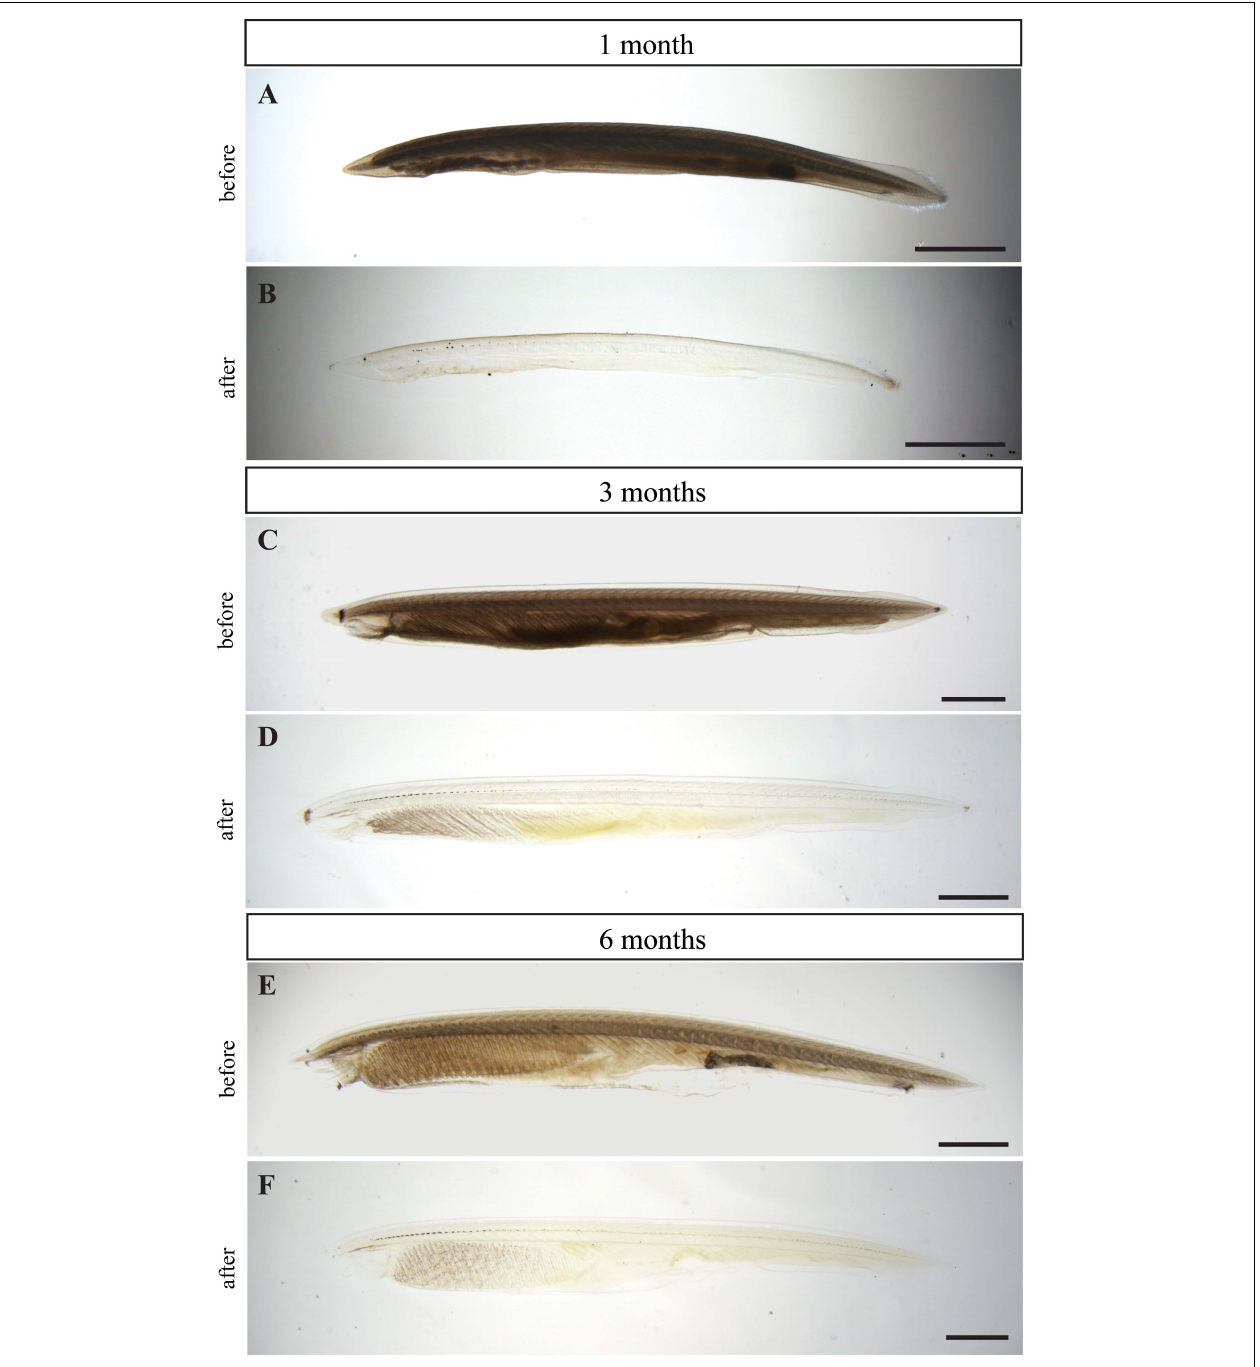
FIGURE 1 | Clearing effect of CUBIC technique on larvae and juveniles of B. floridae . One-month-old larva before (A) and after clearing (B) , 3-month-old juvenile before (C) and after clearing (D) , and 6-month-old juvenile before (E) and after clearing (F) . Larvae and juveniles depicted before and after clearing came from the same batch and were raised in the same conditions. Wide field microscopy with transmitted light was used for imaging all specimens. Scale bar 0.5